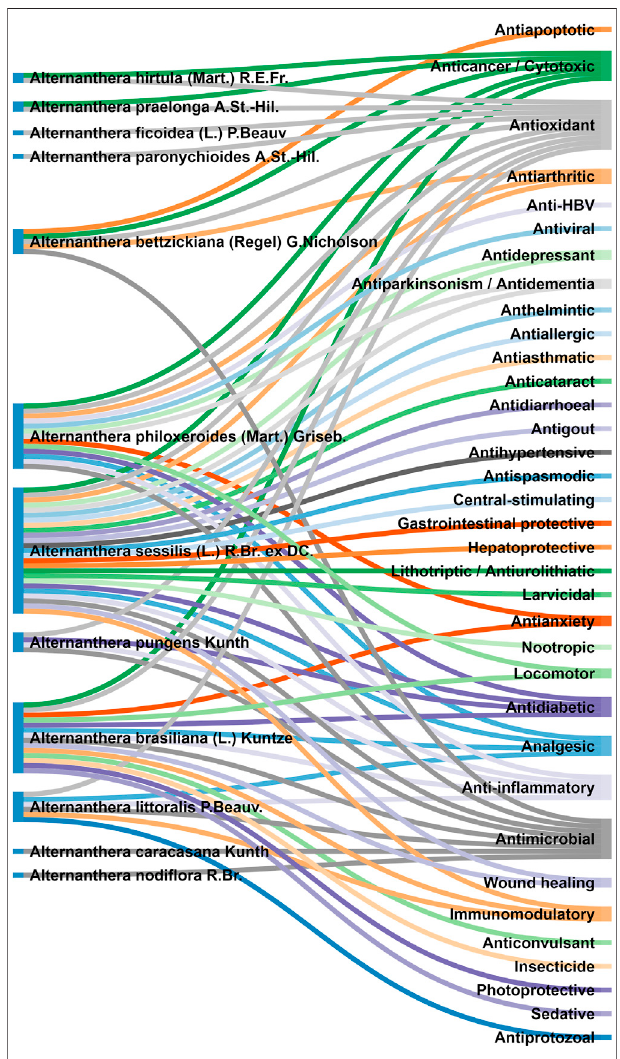
FIGURE 3 | Interactive analysis mapping between various species of Alternanthera genus and their elicited pharmacological properties.